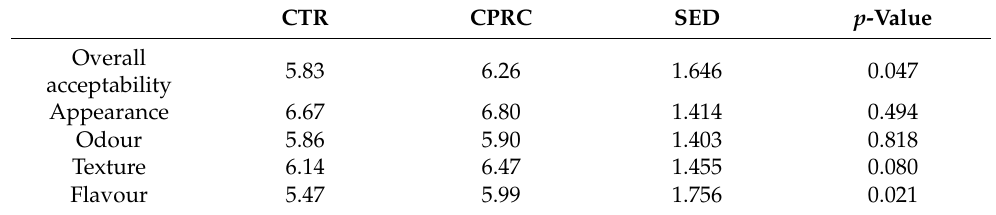
Table 10. Effect of feeding cold-pressed rapeseed cake on milk sensorial quality of lactating dairy cows ( n = 40). CTR CPRC